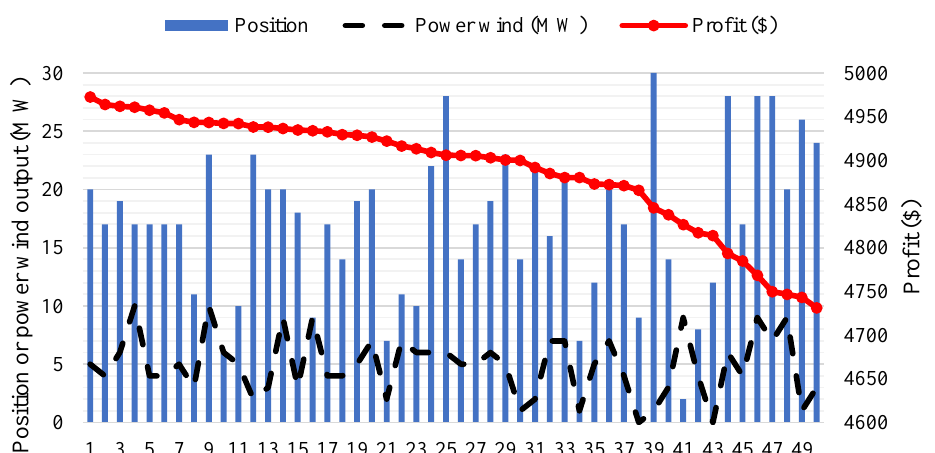
Figure 14. Optimal location and size of wind turbine obtained by MSA for 50 runs.